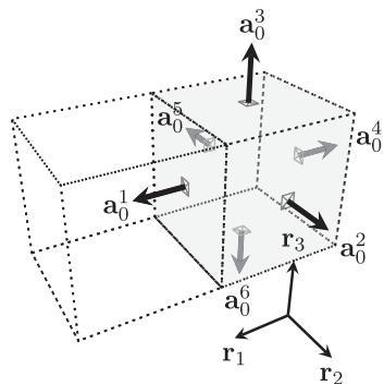
Exemplary orthogonal cell with basis triad r r r 1 2 3 , , in reference configuration 0. Interfaces between neighboring material points are characterized by their outward pointing normals an 0 and have an area of An 0 . Figure adopted from.